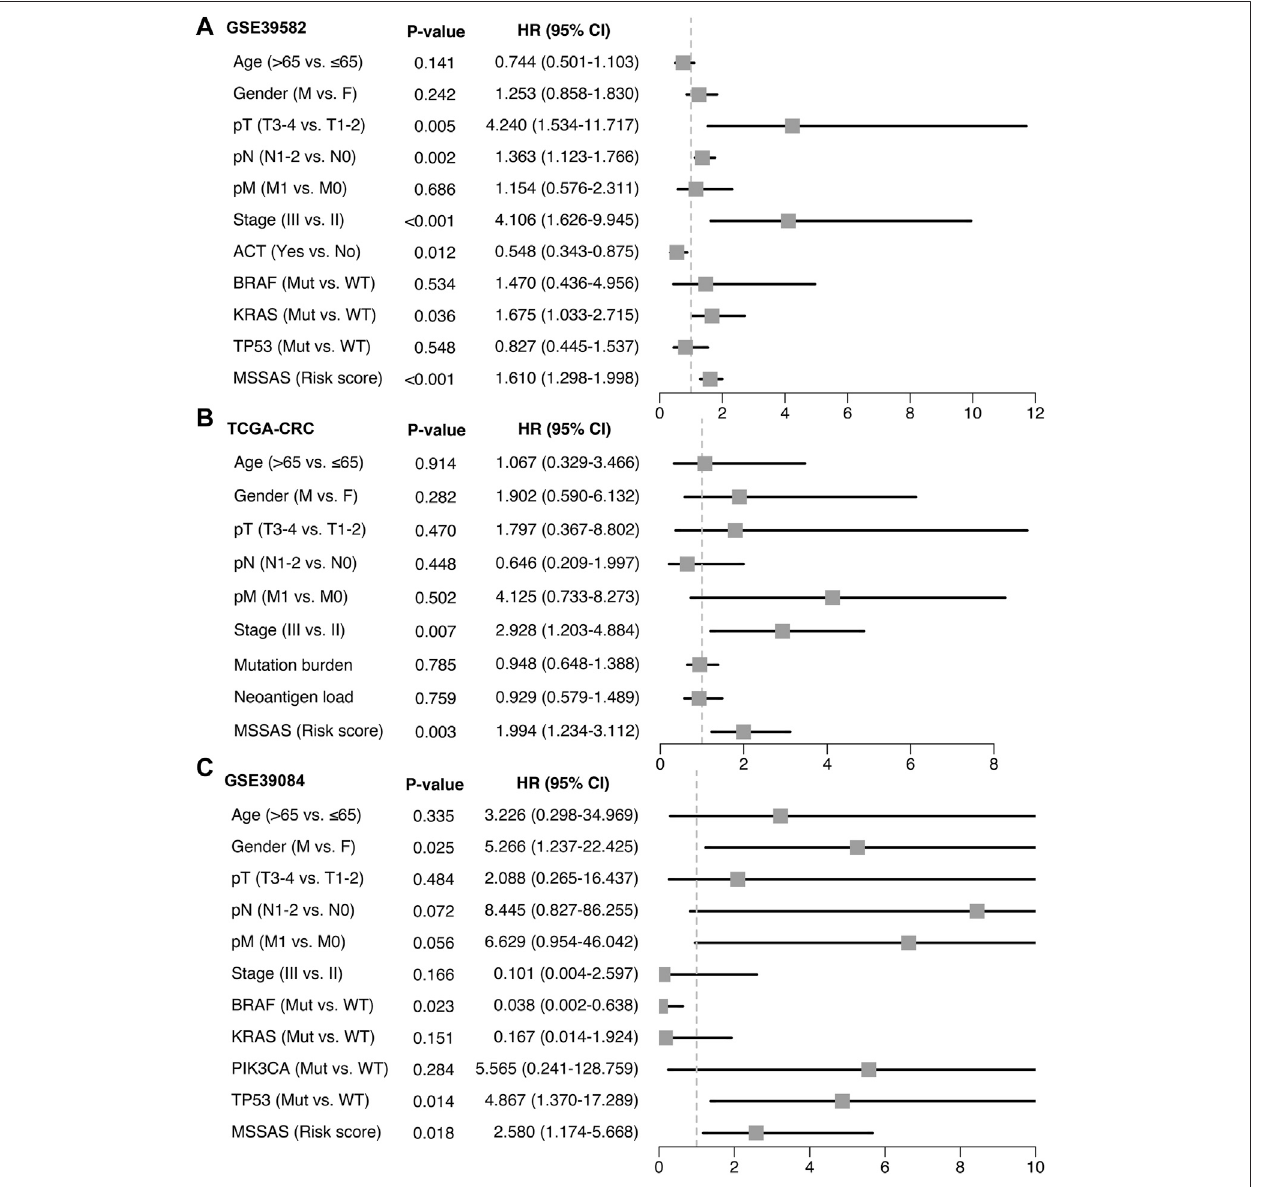
FIGURE 6 | Multivariable Cox regression analysis of RFS. Multivariable Cox regression analysis of MSSAS for RFS in GSE39582 (A) , TCGA – CRC (B) , and GSE39084 (C) .